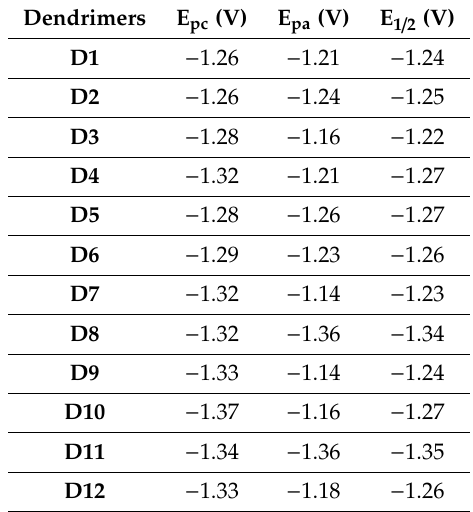
Table 1. Redox activity of dendrimers 1–12 at 0 ◦